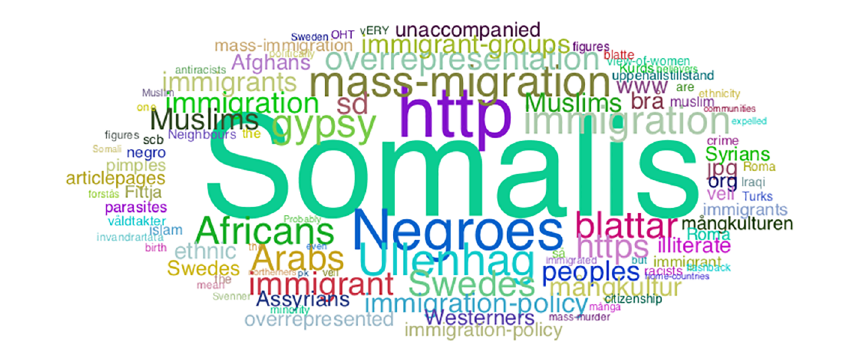
Figure 1a. Word cloud of words with a relative higher word frequency in the forum compared to the Swedish version of Google N-grams, using chi-square tests. Colored words are significant following Bonferroni correction for multiple comparisons, and grey words are significant at p < .05. Font size is proportional to the relative Chi-square value.